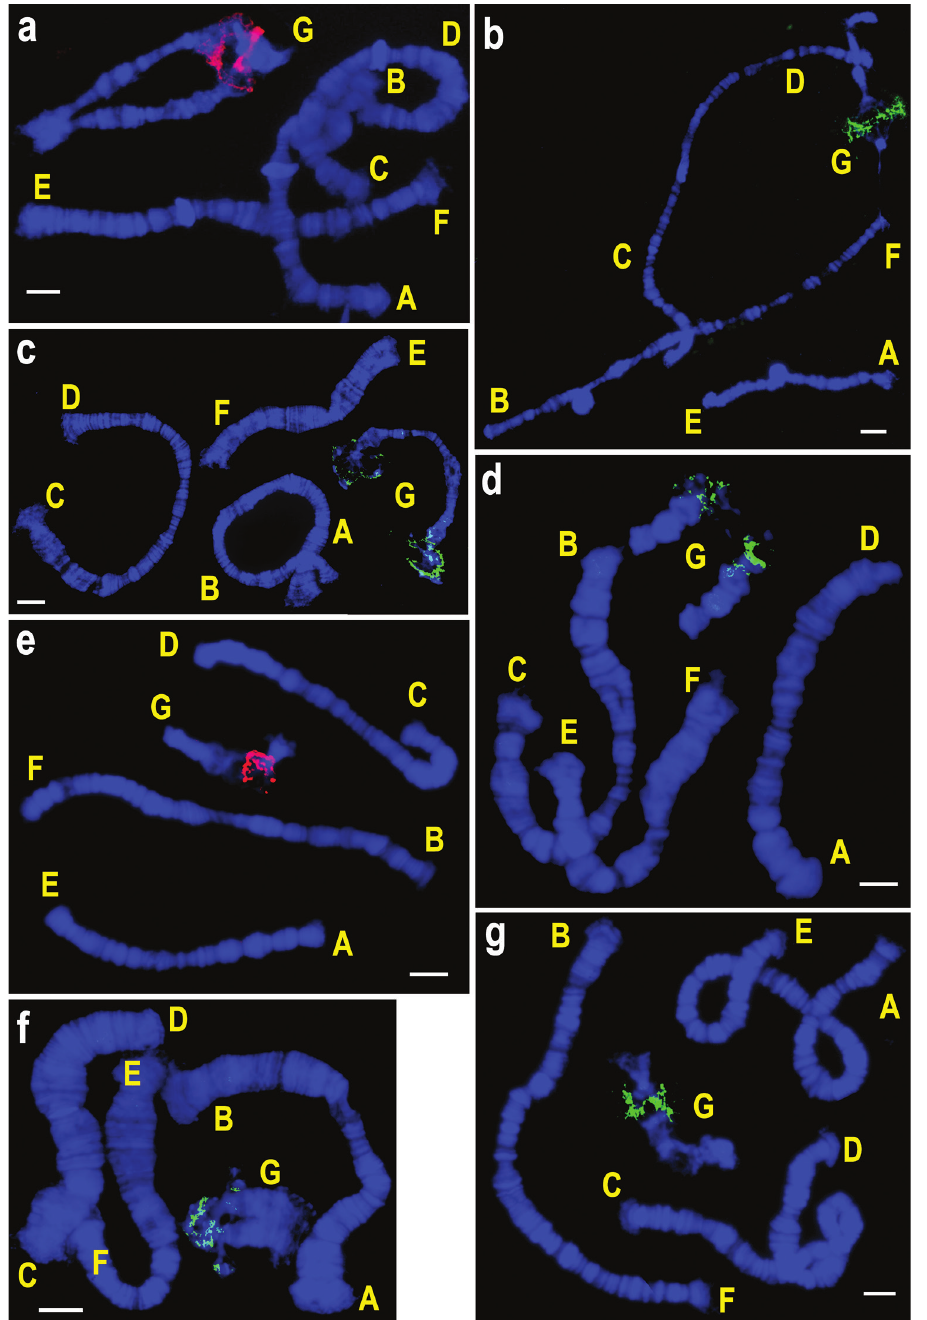
Figure 2. FISH of rDNA probes on polytene chromosomes of species from the subgenus Chironomus with one NOR in karyotype. a Ch. borokensis b Ch. dorsalis c Ch. entis d Ch. lacunarius e Ch. luridus f Ch. nuditarsis g Ch. melanescens